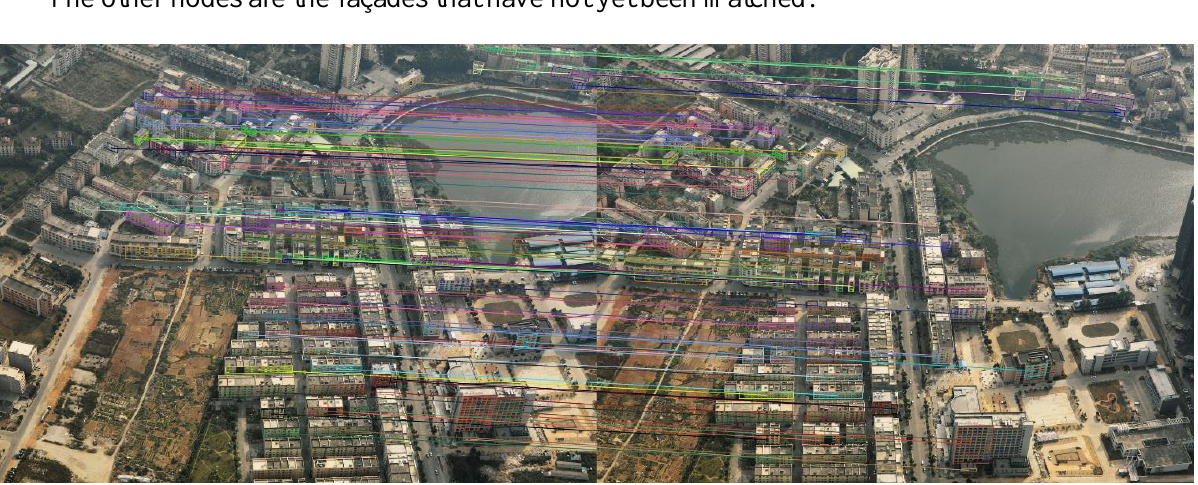
Figure 16. Selection and matching of seed façades based on regional descriptions after the outliers were removed using RANSAC. The blue and white circles denote the candidate seed façades based on the regional description. The blue circles are the final seed façades, and the white circles are considered to be outliers and were removed by the RANSAC algorithm.